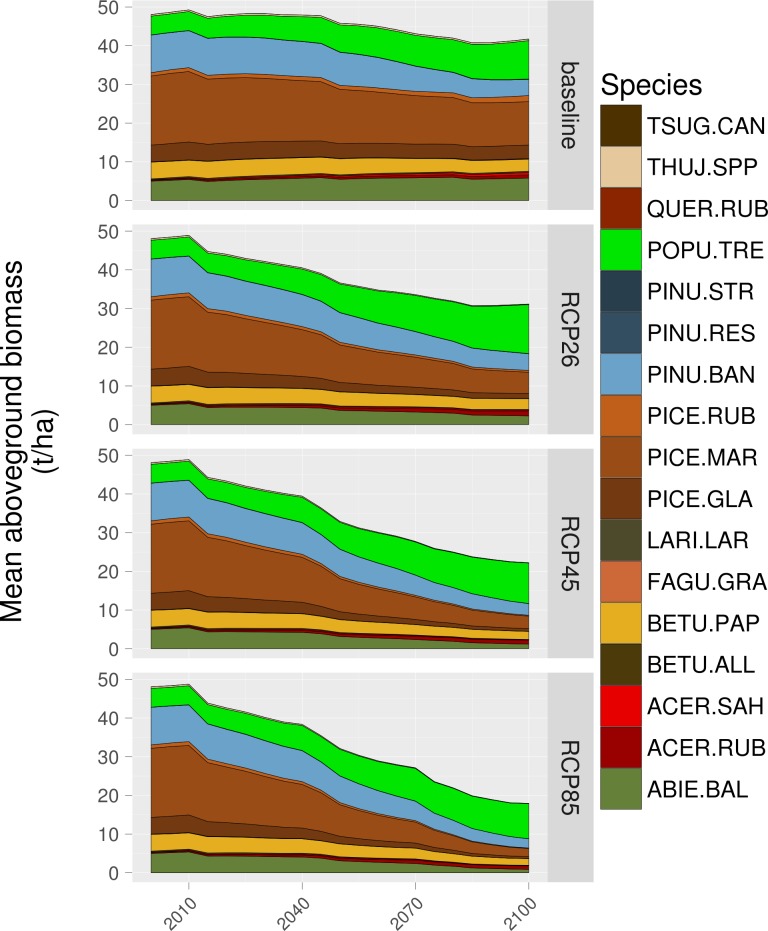
Projected cumulated changes in tree species AGB under baseline, RCP 2.6, RCP 4.5 and RCP 8.5 climate scenarios.